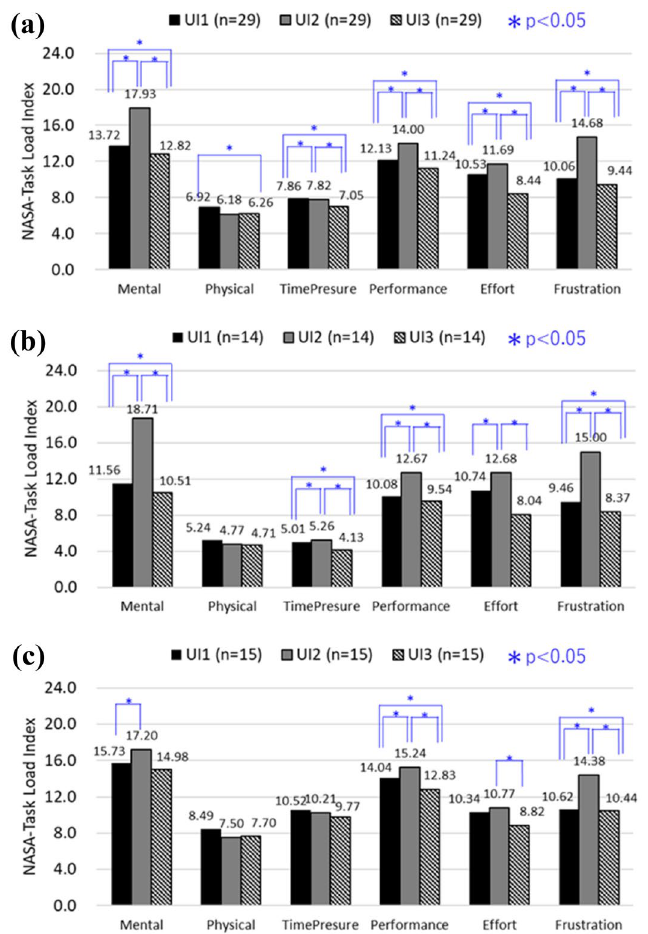
Figure 13. Weighted NASA-TLX responses for ( a ) all subjects, ( b ) experts, and ( c )